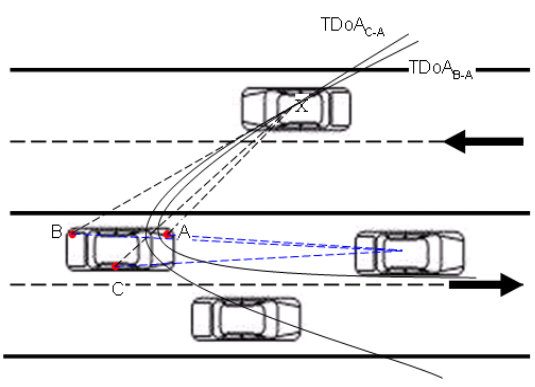
Fig.3. Time Difference of